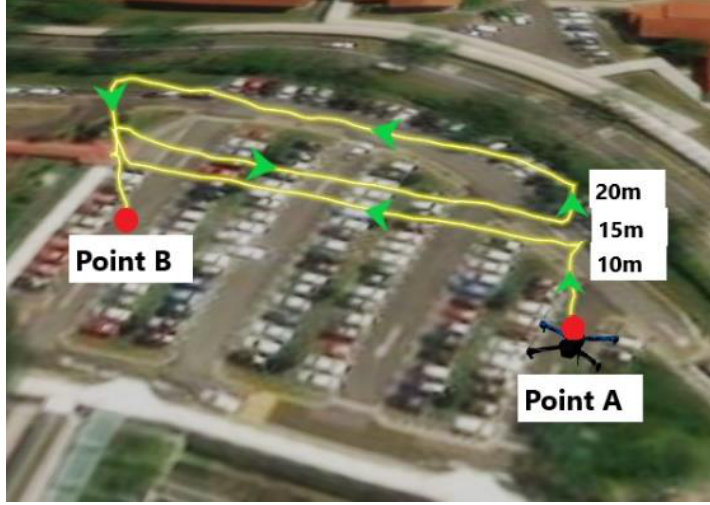
Figure 7. An Illustration of the Flight Path and Points A & B in Car Park F.